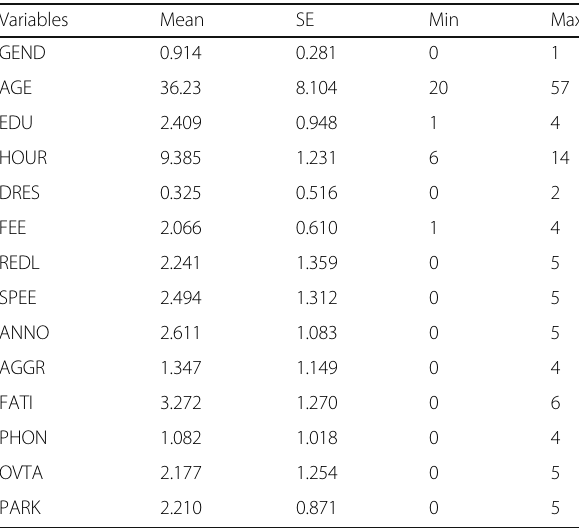
Table 2 Descriptive characteristic for